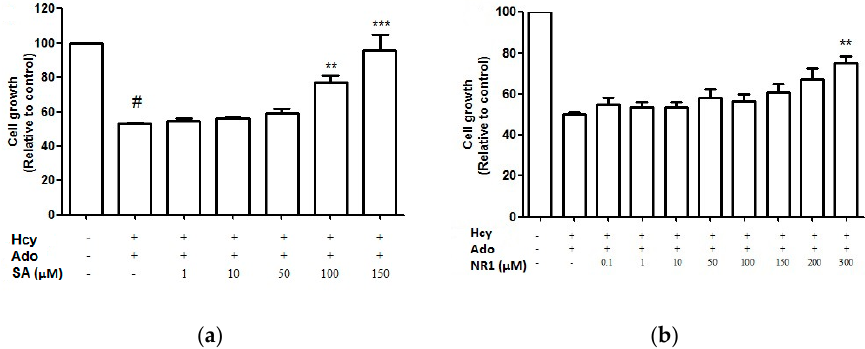
Figure 6. Cell growth (relative to control)-dose-response curves for SA ( a ) and NR1 ( b ) from DS and SQ, respectively. # p < 0.05 compared to blank control, * p < 0.05 compared to Hcy-Ado stimulation only.